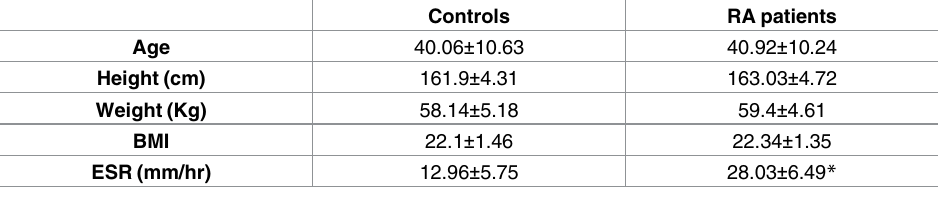
Table 1. Baseline characteristics of healthy controls and rheumatoid arthritis patients. The valuesrep- resents the mean ±